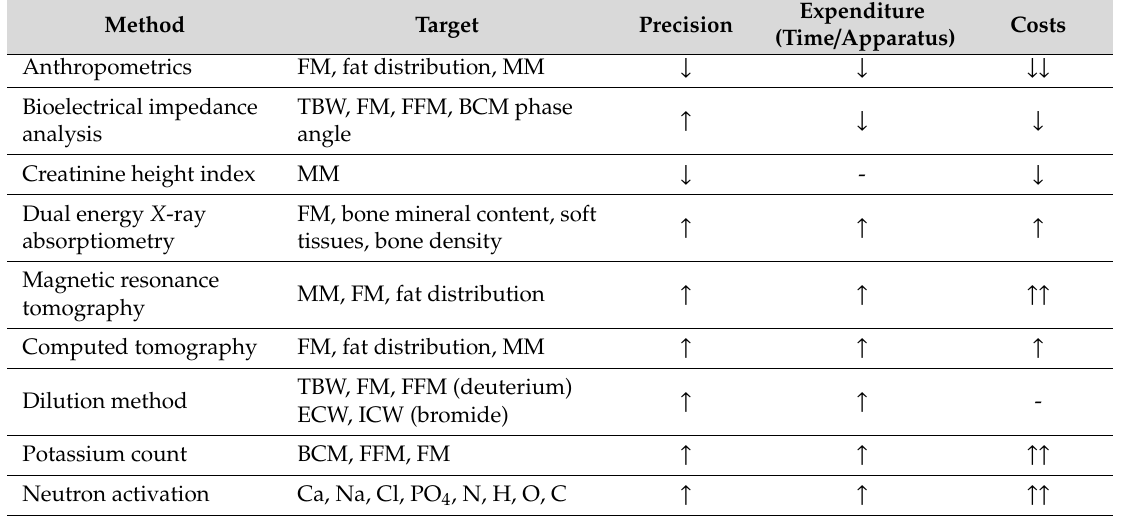
Figure 1. Compartment models of body composition. FFM: fat-free mass, FM: fat mass, BCM: body cell mass, ECM: extracellular cell mass. Modified after [40].